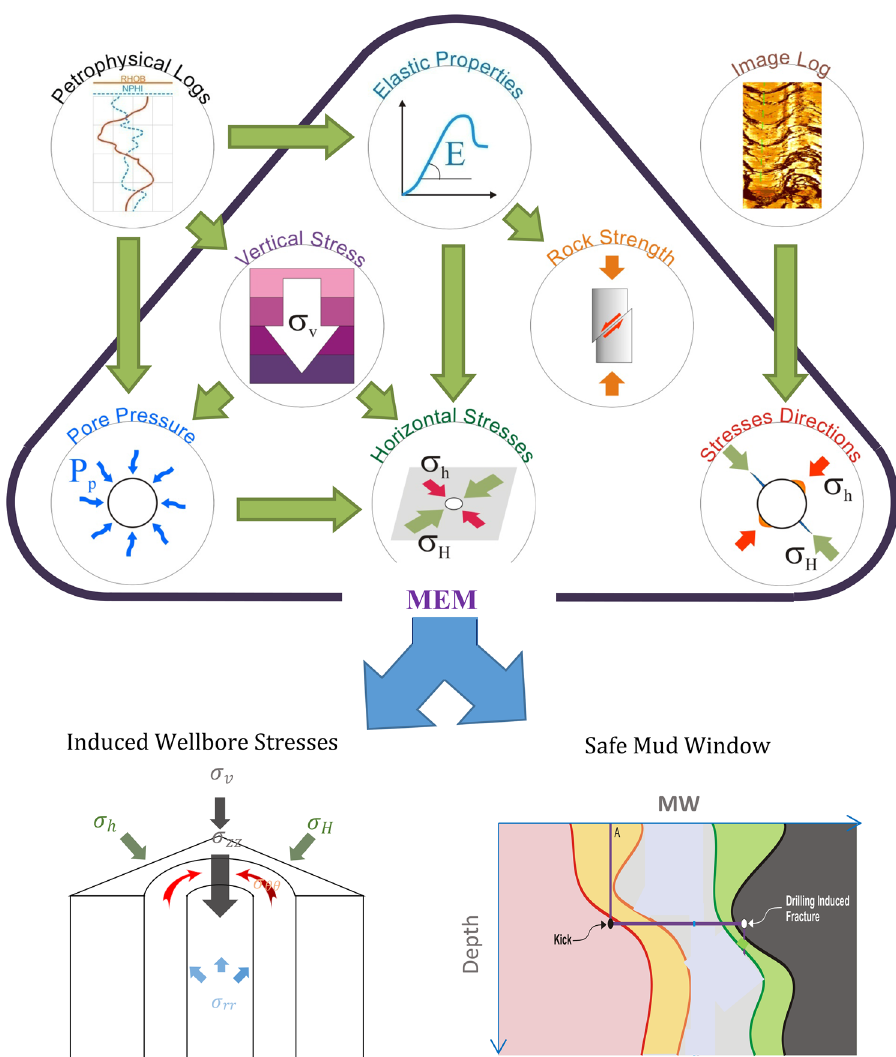
Fig. 9 Constructing the mechanical earth model (MEM) for WBS providing induced stresses and safe mud